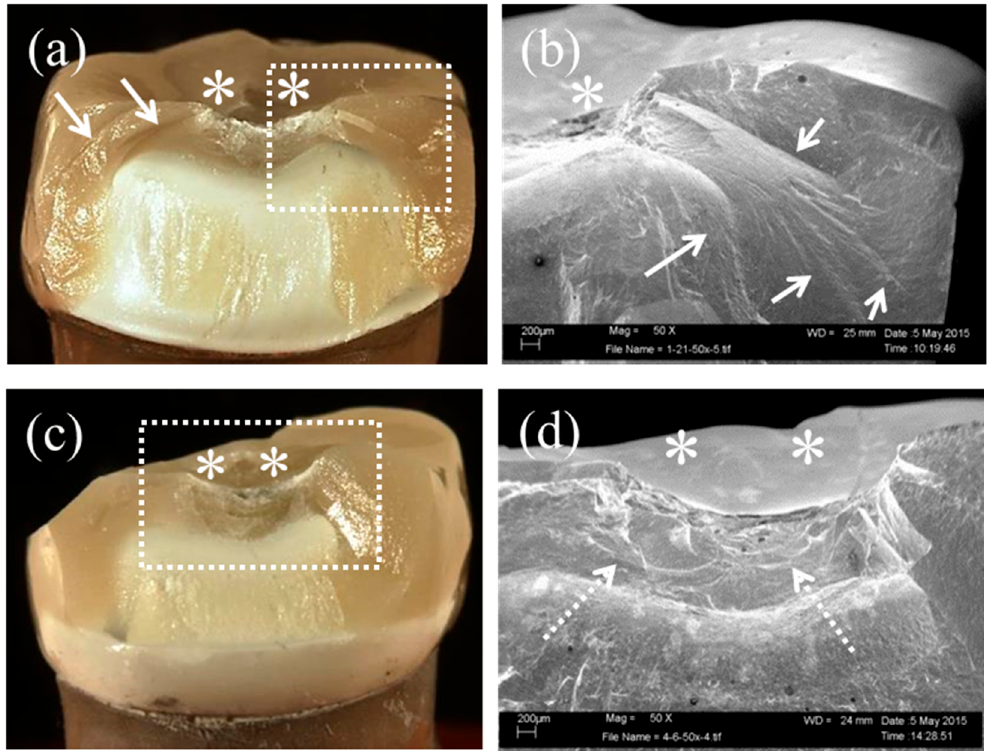
Figure 6. Lingual side views of microscopy (overview; left) and scanning electron microscopy (detail; right) observation; non-lingual supporting structure ( a , b ); lingual supporting structure ( c , d ). White arrows, white dotted arrows, and asterisks indicate fracture lines, arrest lines, and load-bearing points, respectively.